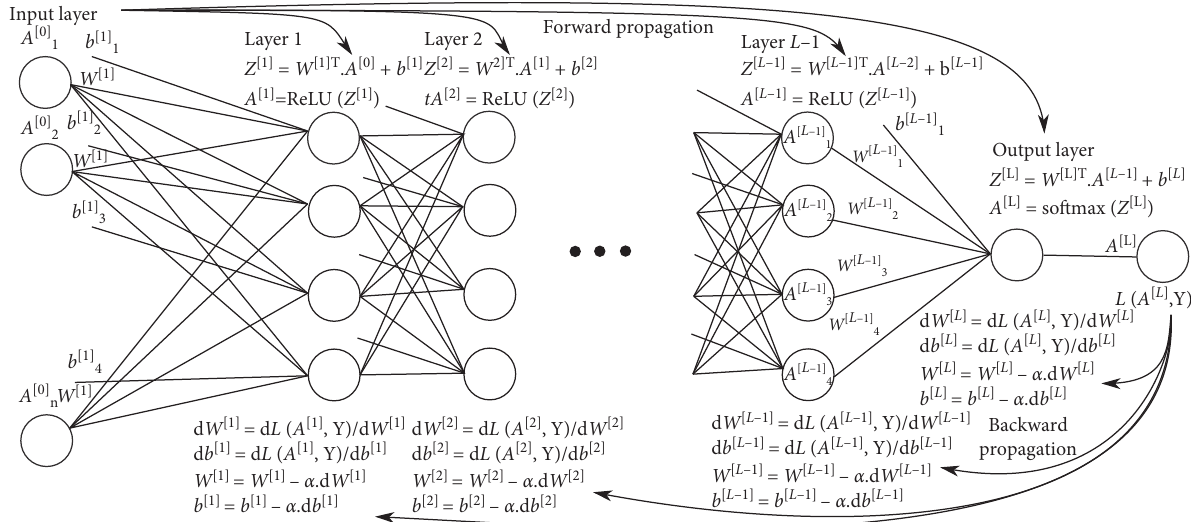
Figure 3: A sample architecture of deep neural network.